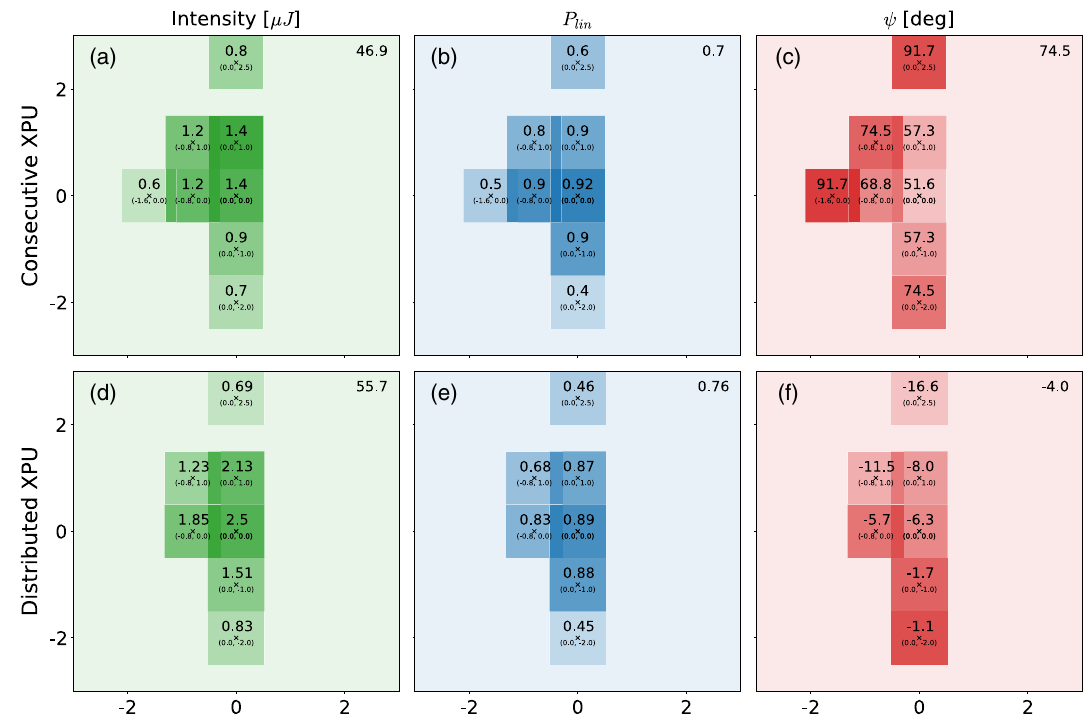
FIG. 15. Intensity (in μ J), degree and direction (in deg) of the linear polarization for the circular XPU for different beam defining aperture positions (in mm). (a, b, c) are relative to the consecutive scheme, while (d, e, f) refer to the distributed scheme. The value of each quantity is reported in the boxes that represent each different aperture position (on the top right corner for the larger aperture). One can clearly see that in both configurations the polarization properties change along the wavefront, due to phase and amplitude variations between the interfering fields. The reported values represent the average over 500 shots. The different rate of change for ψ between the horizontal and vertical direction suggests either that the photon beam was slightly elliptical during our measurements, or that the different sources were not perfectly